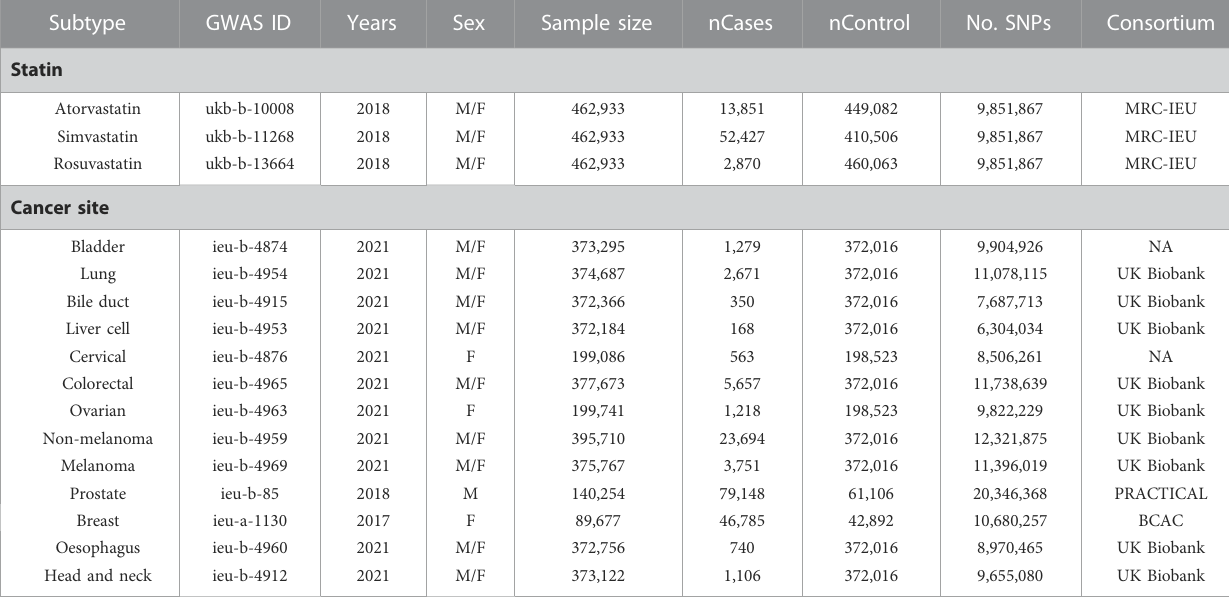
TABLE 1 The list of Genome-wide summary association studies (GWAS) included in the Mendelian randomization (MR) study.